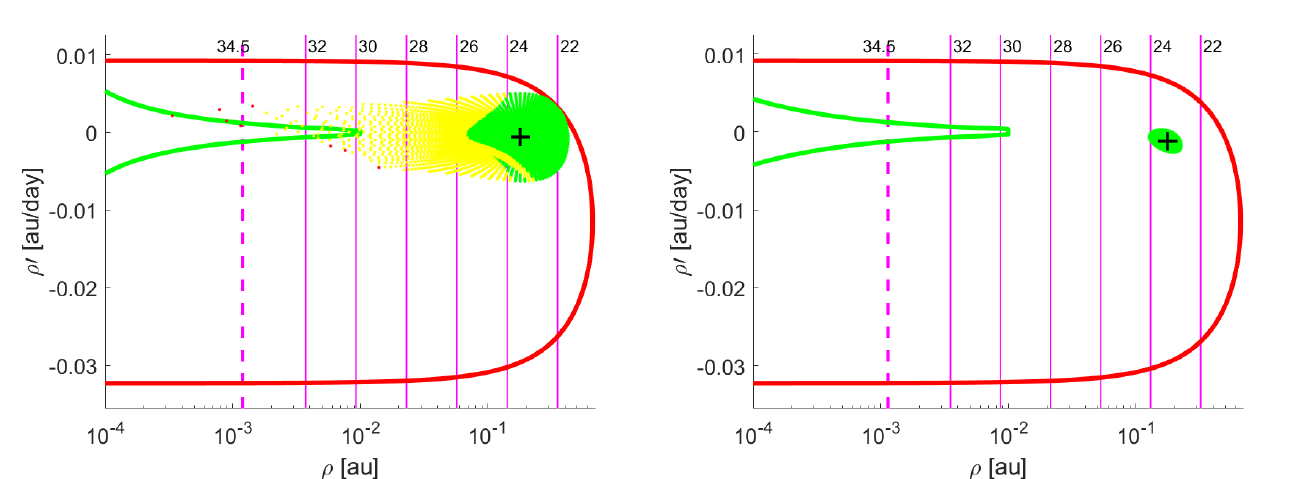
Figure 10. Tool 1 tested on tracklets of five observations (left) and 11 observations (right) for asteroid